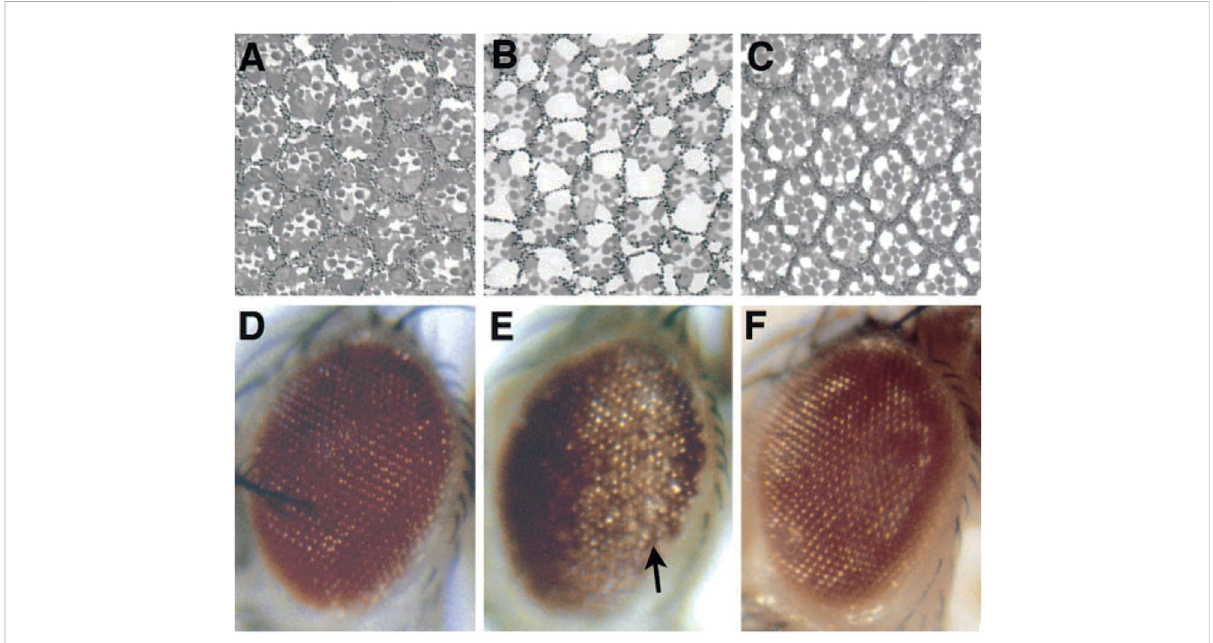
FIGURE 2 The progressive nature of a disease gene phenotype in Drosophila . Expression of a toxic polyglutamine disease protein associated with the human disease SCA3 in the fl y eye shows progressive deterioration of the eye with age. When weakly expressed, the protein has minimal effects on theinternal (A) andexternaleye (D) whentheanimal fi rstemergesasanadult. (B,E) Butoverjust4 days,theeyeundergoesdrasticdeterioration. (C,F) Eye expressing non-toxic protein for comparison, which is normal. From (Warrick et al., 1998) with